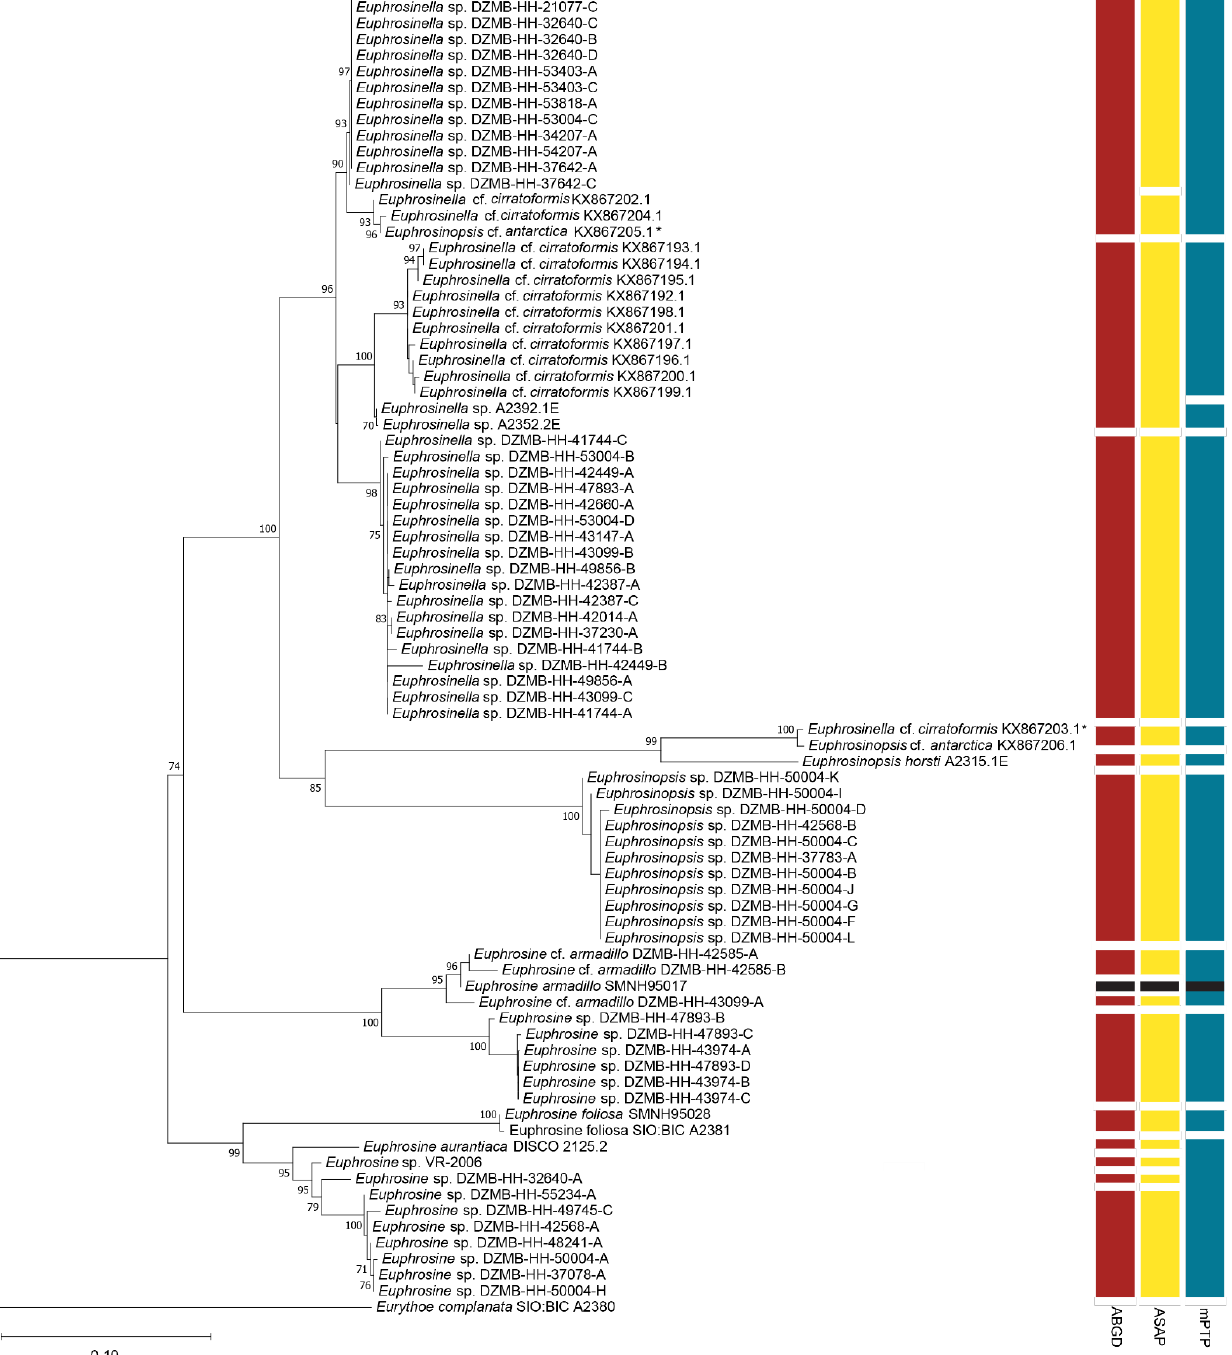
Figure 3. Phylogenetic analysis of Euphrosinidae based on 16S and 28S with results of three different species delimitation methods. Bootstrap support values below 70 are not shown. Asterisks indicate publicly available sequences where the original identification appears to be incorrect. Note that DZMB- numbers represent field collection codes and not museum catalaog numbers. Because of their small size, most of these specimens were destructively sampled for DNA extraction and thus museum catalog numbers are not available for these specimens.